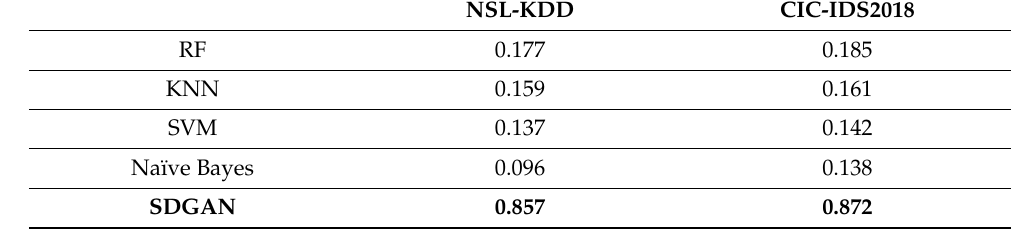
Table 8. TPRs of ML-based DDoS detectors and SDGAN on adversarial DDoS attacks.